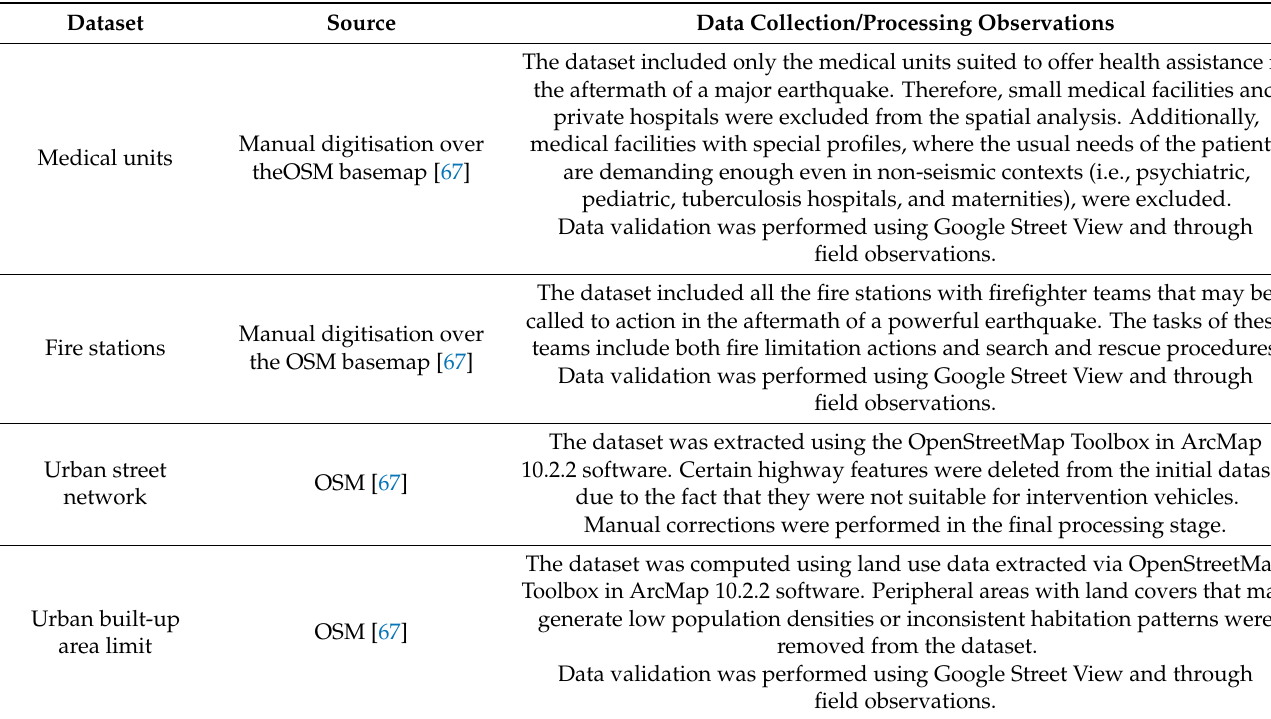
Table 2. Dataset details and